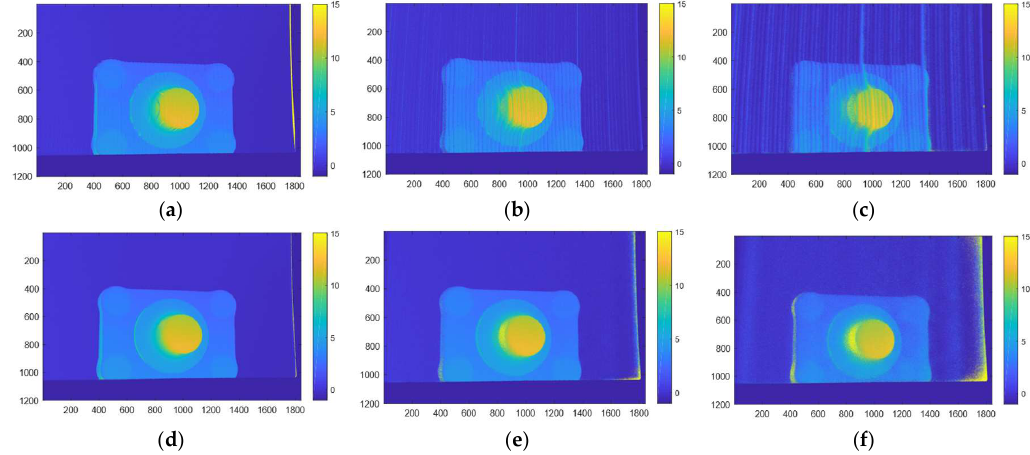
Figure 12. Qualitative results from imaging the object in Figure 7. Results in cm. ( a – c ): Results from GCPS. ( d – f ): Results from scatter corrected MFPS. The three columns represent turbidities (left to right) λ 0 = 5.9 m, λ 2 = 1.1 m and λ 3 = 0.8